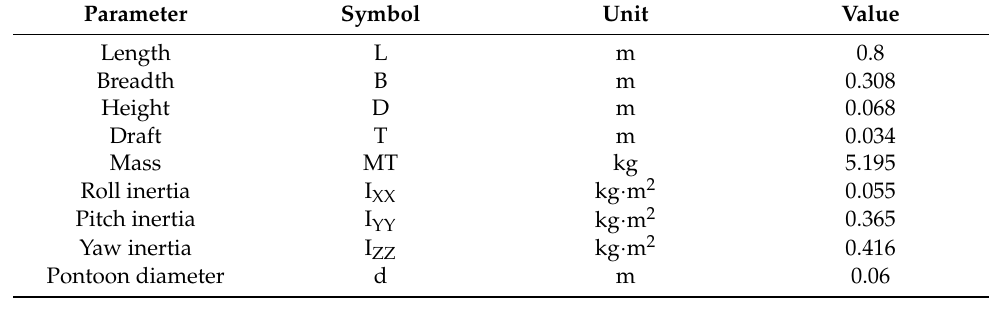
Table 1. Main parameters of floating breakwater model.